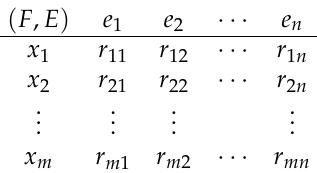
Figure 1. The tabular representation of a soft set ( F , E )